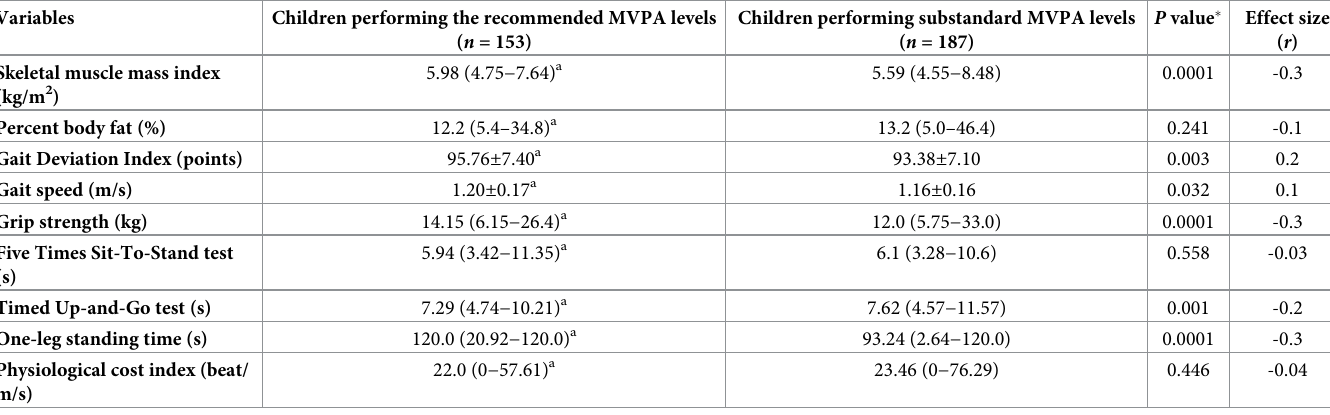
Table 2. Physical function outcomes of study